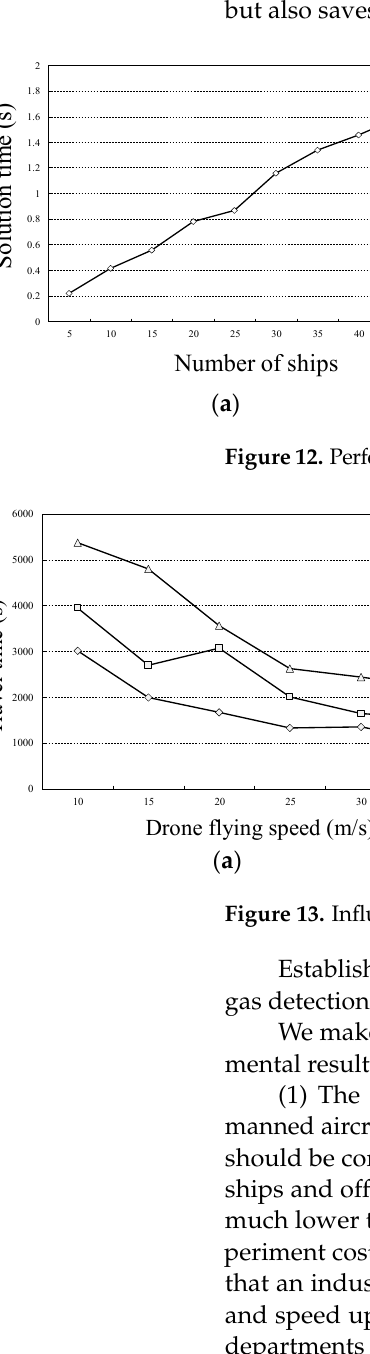
Figure 11. Influence of crossover rate and mutation rate on genetic algorithm.